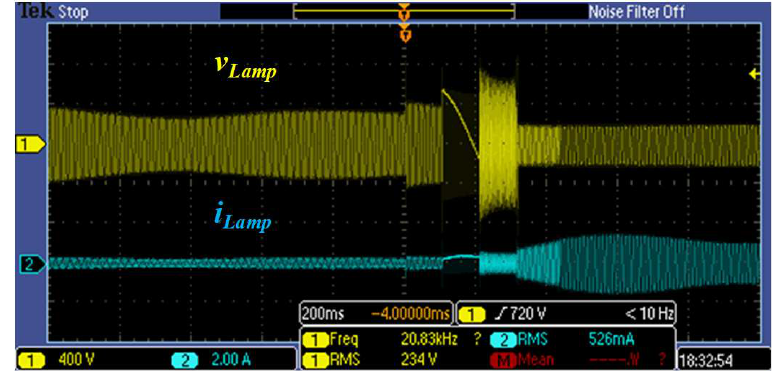
Figure 13. EFL Lamp voltage ( v lamp ) and current ( i lamp ) during the ignition transient.